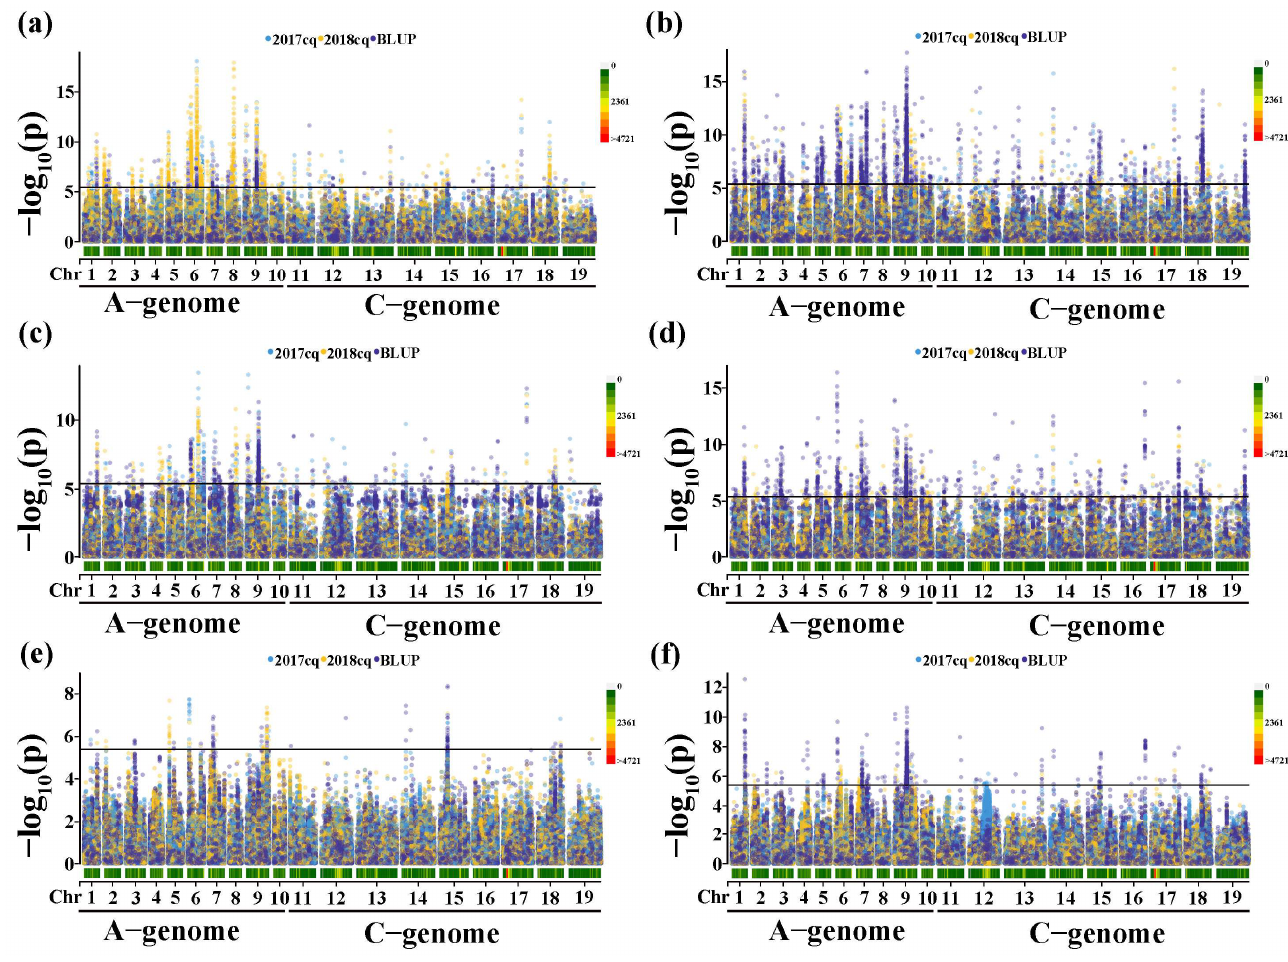
Figure 3. Manhattan plots of association analysis for six glucosinolate metabolites. ( a ) Manhattan plot for m145 in 2017cq, 2018cq and BLUP values. ( b ) Manhattan plot for m150 in 2017cq, 2018cq and BLUP values. ( c ) Manhattan plot for m151 in 2017cq, 2018cq and BLUP values. ( d ) Manhattan plot for m157 in 2017cq, 2018cq and BLUP values. ( e ) Manhattan plot for m165 in 2017cq, 2018cq and BLUP values. ( f ) Manhattan plot for m172 in 2017cq, 2018cq and BLUP values. Different-colored spots represent different environments. The horizontal lines indicate the Bonferroni-adjusted significance threshold (4.17 × 10 −6 ).